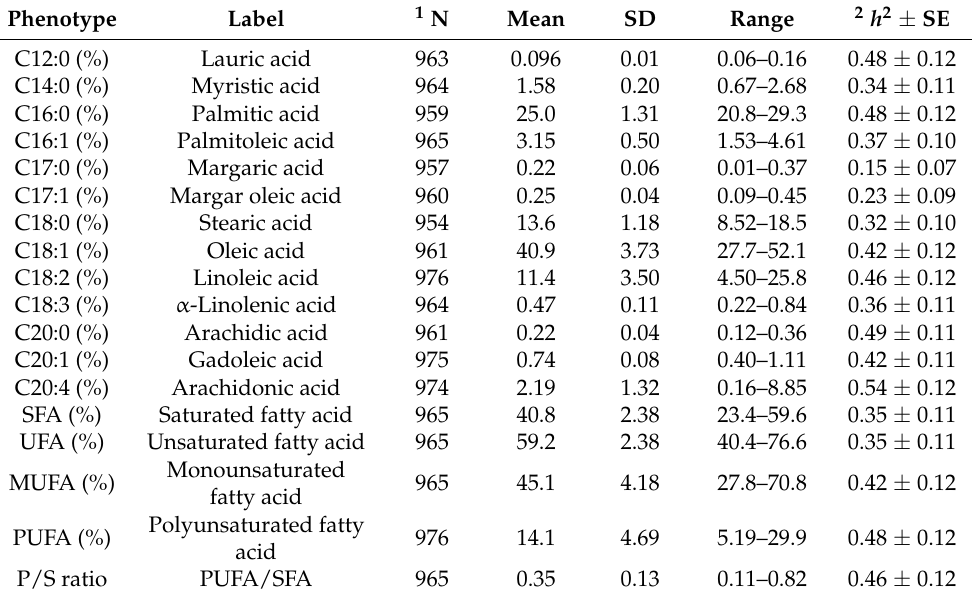
Table 1. Summary of fatty acid composition data from the F2 generation of an intercross between Landrace and Korean native